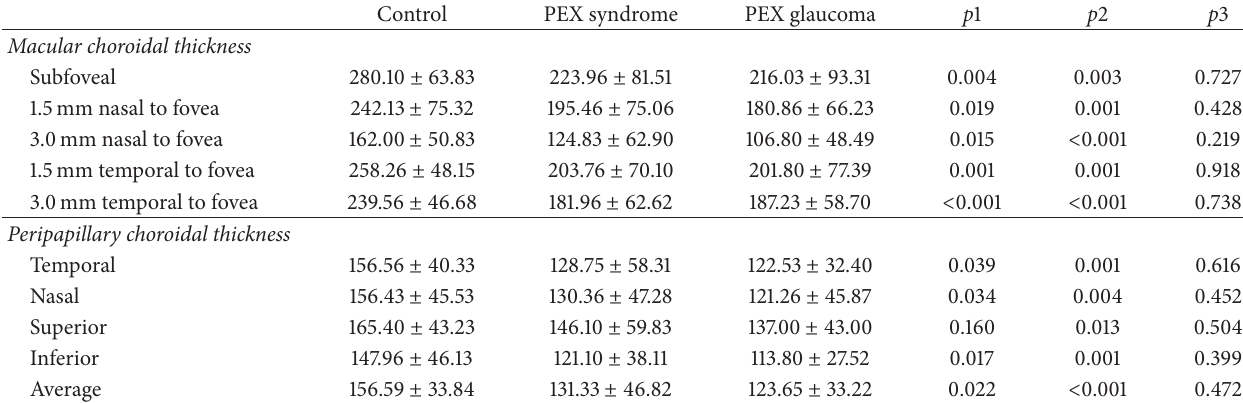
Table 2: Mean thicknesses of the macular and peripapillary choroid in each